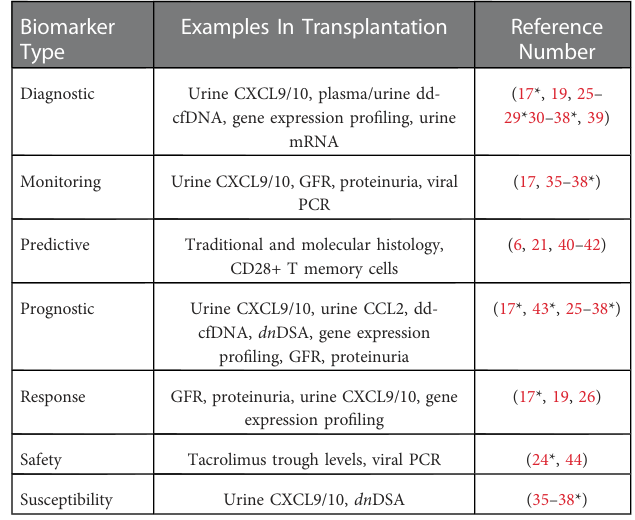
TABLE 1 Classes of biomarkers in kidney transplantation. The seven classes of biomarkers in the FDA-NIH BEST resource are listed with clinical and investigational examples of each type and corresponding references. Some examples can be used as multiple types of biomarkers based on available